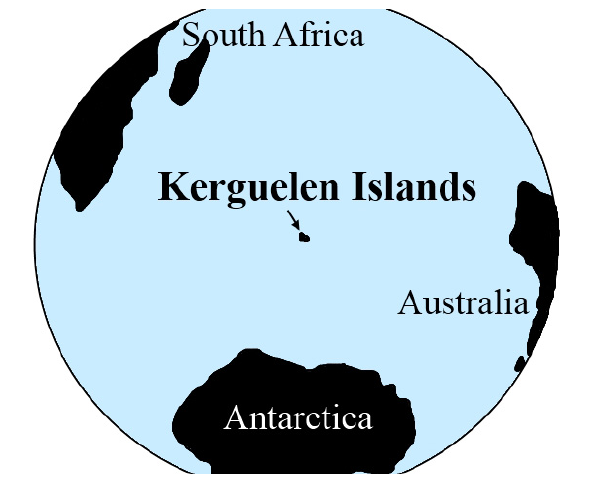
Fig. 1a. The Kerguelen Islands in the Southern Indian Ocean.